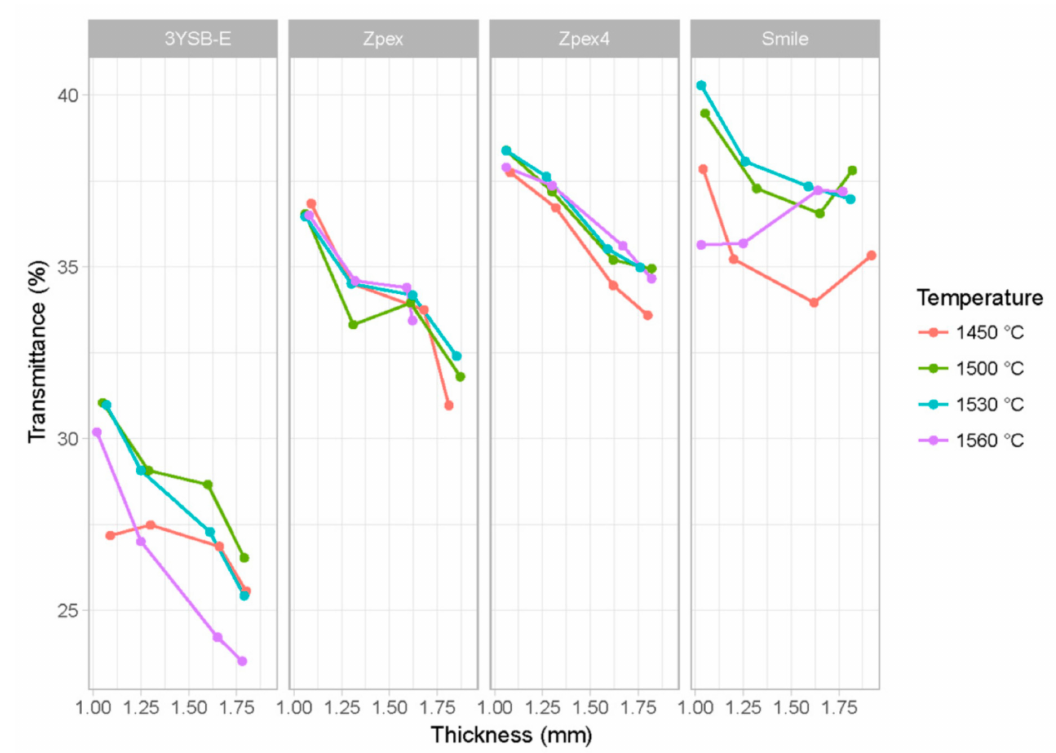
Figure 4. Observed transmittance data for λ equal to 710 nm as a function of sintering temperature, zirconia type, and thickness